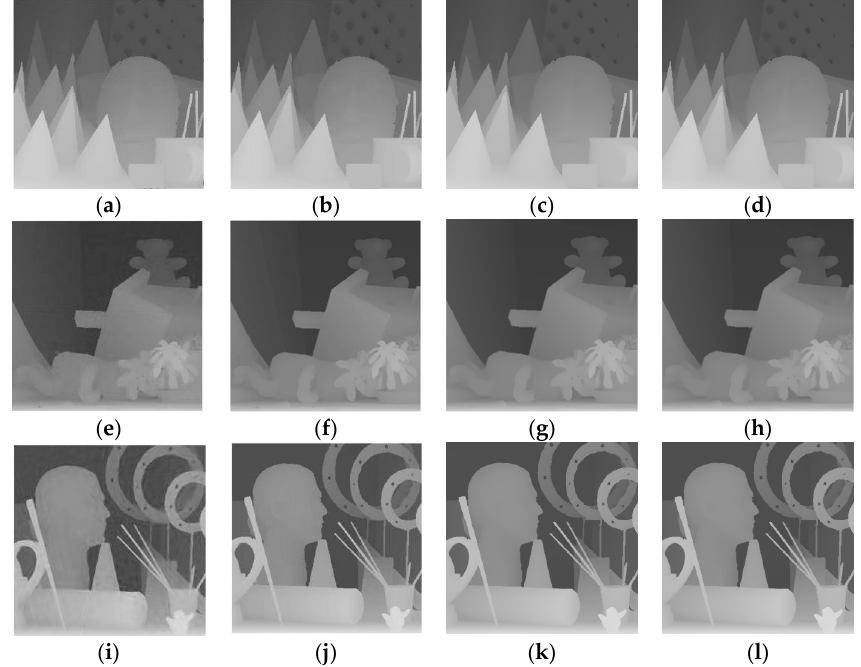
Figure 4. Visual contrasting of the inpainting results (1): ( a ) – ( d ) represent the inpainting effects of the four algorithms (total variation (TV), group ‐ based sparse representation (GSR), low rank with L0 gradient regularization (LRL0) and the proposed algorithm) for the mask depth image; ( e )–( h ) represent the inpainting effects of the four algorithms (TV, GSR, LRL0 and the proposed algorithm) for the toy depth image; and ( i )–( l ) represent the inpainting effects of the four algorithms (TV, GSR, LRL0 and the proposed algorithm) for the Art depth image.